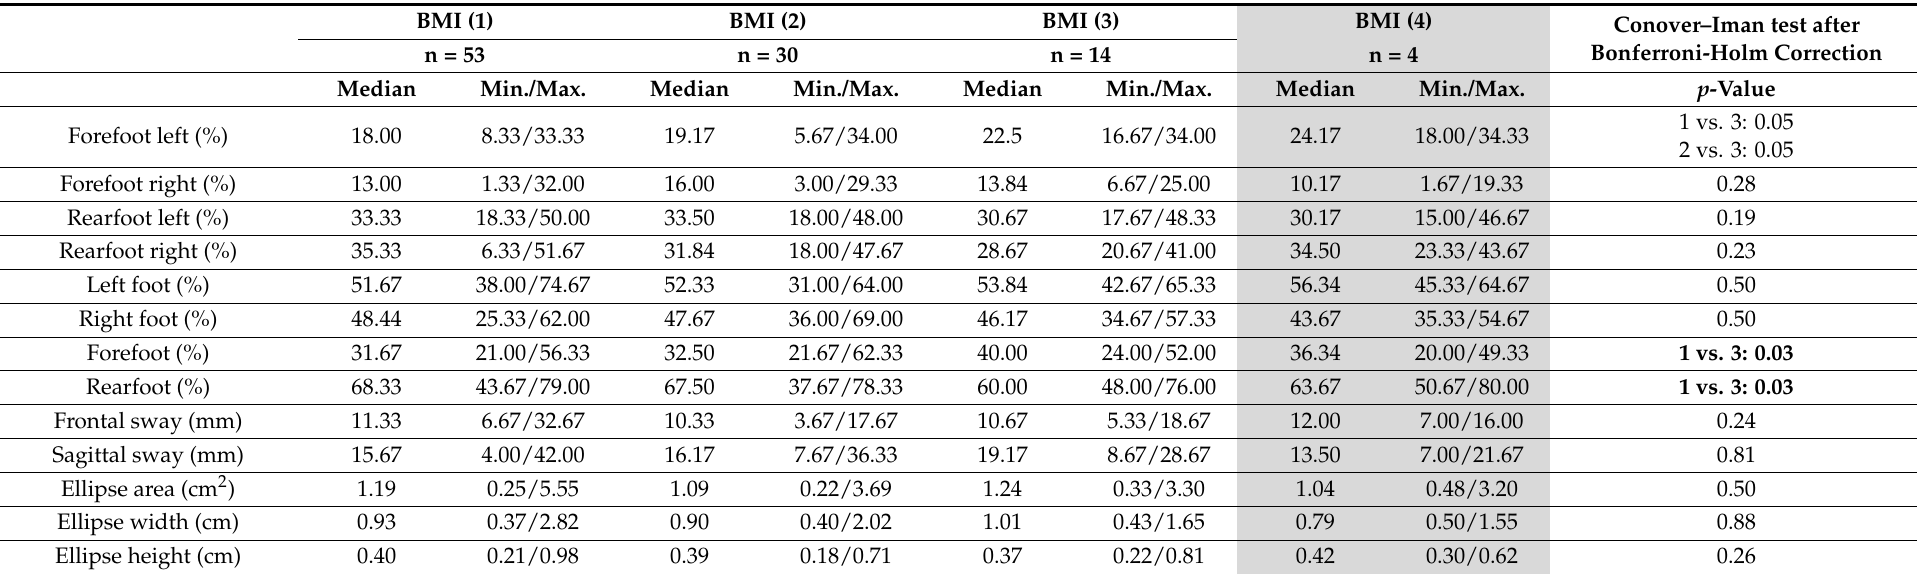
Table 3. Influence of all parameters on the BMI. Median, minimum and maximum of the parameters surveyed in subjects with different BMI groups (1 = normal; 2 = pre-obese; 3 = obese; 4 = underweight). Since the number of cases was too low, BMI group 4 was not included in the calculations and is, therefore, highlighted in gray. Significant p -values are shown in bold; n = number of